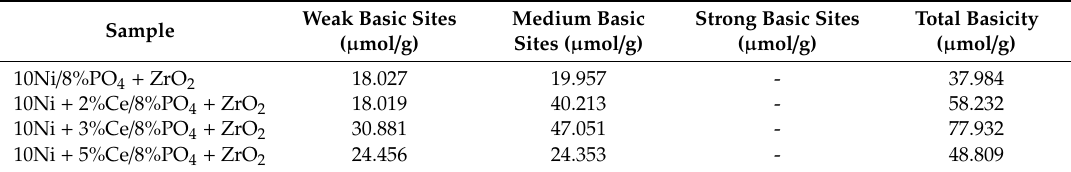
Figure 4. CO 2 -TPD profiles of 10Ni + z%Ce / 8% PO 4 -ZrO 2 (z = 0, 1, 3, and 5) catalysts. Table 3. Distribution of basic sites for Ni-supported